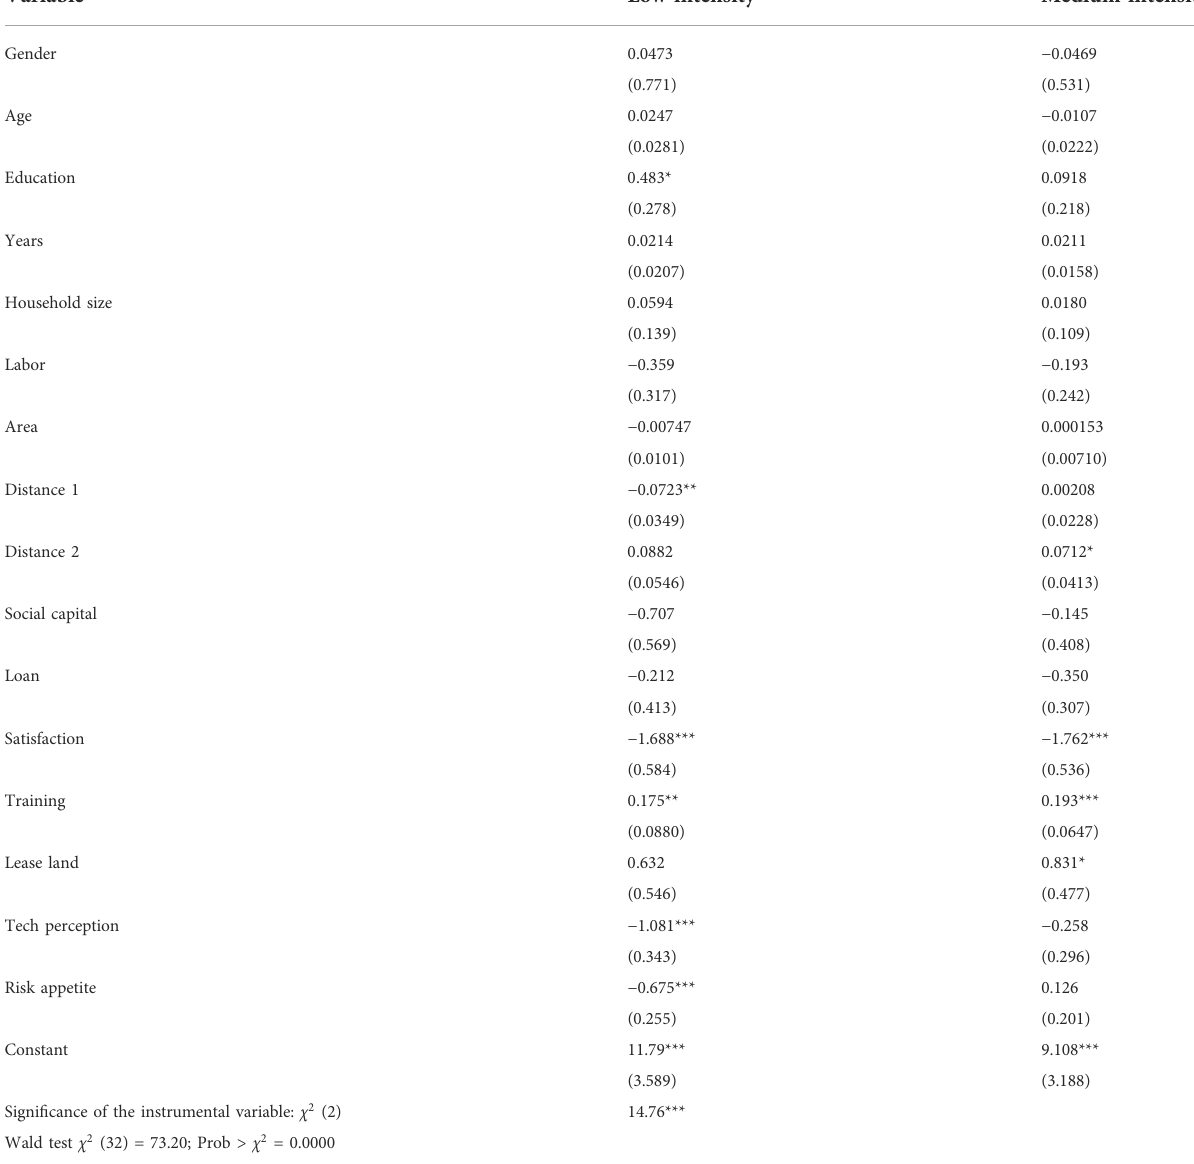
TABLE1MMNLmodelestimationoftheadoptionintensityoftobaccofarmersregarding the standardized technicalsystem inChongqing, China(the baseline is high intensity).